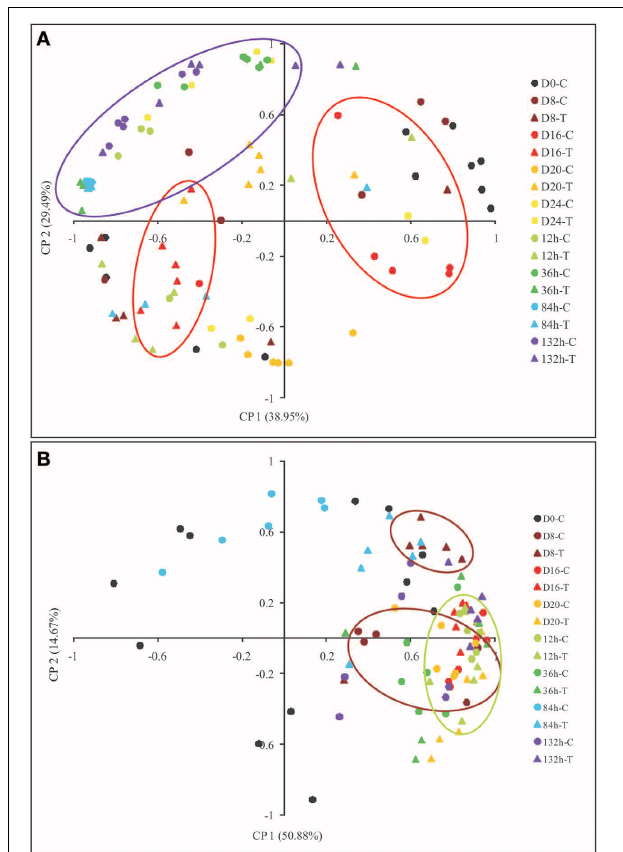
FIGURE 7 | Principal component analysis (PCA) of metabolites of Barbacenia purpurea during dehydration and rehydration. PCA of metabolites quantified in leaves of daily watered plants (C) and plants under water suppression (T), during winter (A) and summer (B) . PCA is presented as the combination of the first two dimensions. Circles and triangles represent control and treated plants, respectively. Black color = Day 0, dark red = Day 8 after dehydration, light red = Day 16, orange = Day 20, yellow = Day 24 (only winter), light green = 12h after rehydration, dark green = 32h, blue = 84h and purple = 132h. Each point represents an independent biological sample. Red and purple circles represent the grouped samples at day 16 after water deficit and at 132h after rehydration in winter, respectively, (A) . Brown and green circles represent the grouped samples at day 8 after water deficit and 132h after rehydration in summer, respectively, (B)